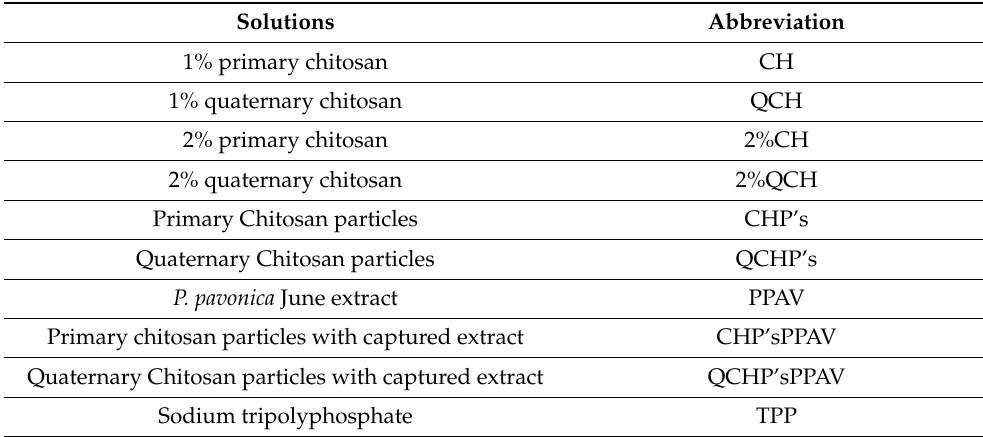
Table 1. Sample description of prepared